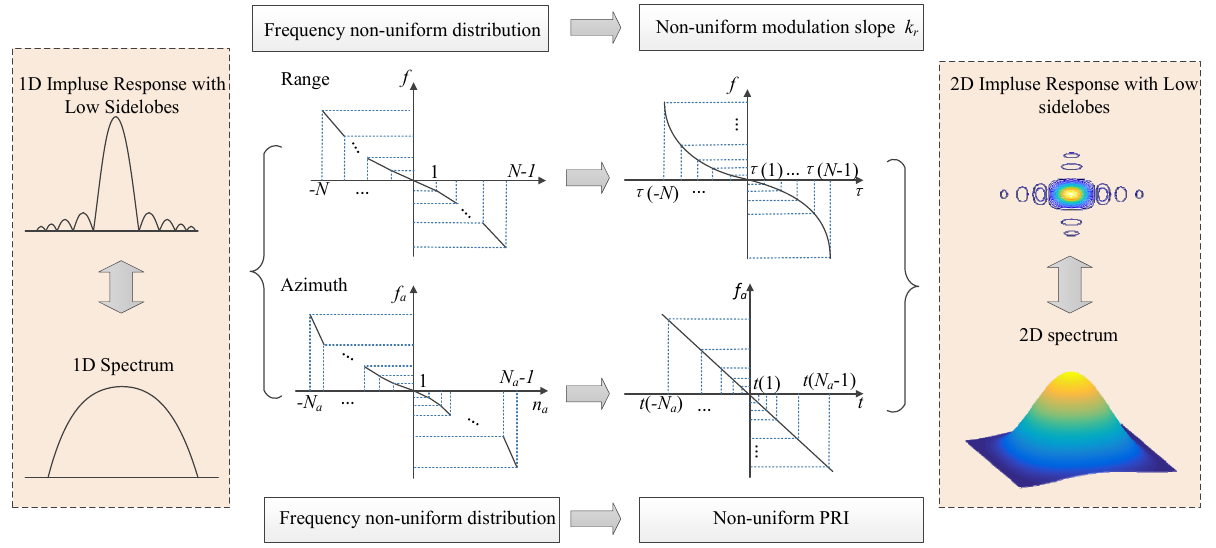
Figure 1. Sidelobe suppression without window weighting in range and azimuth dimensions.